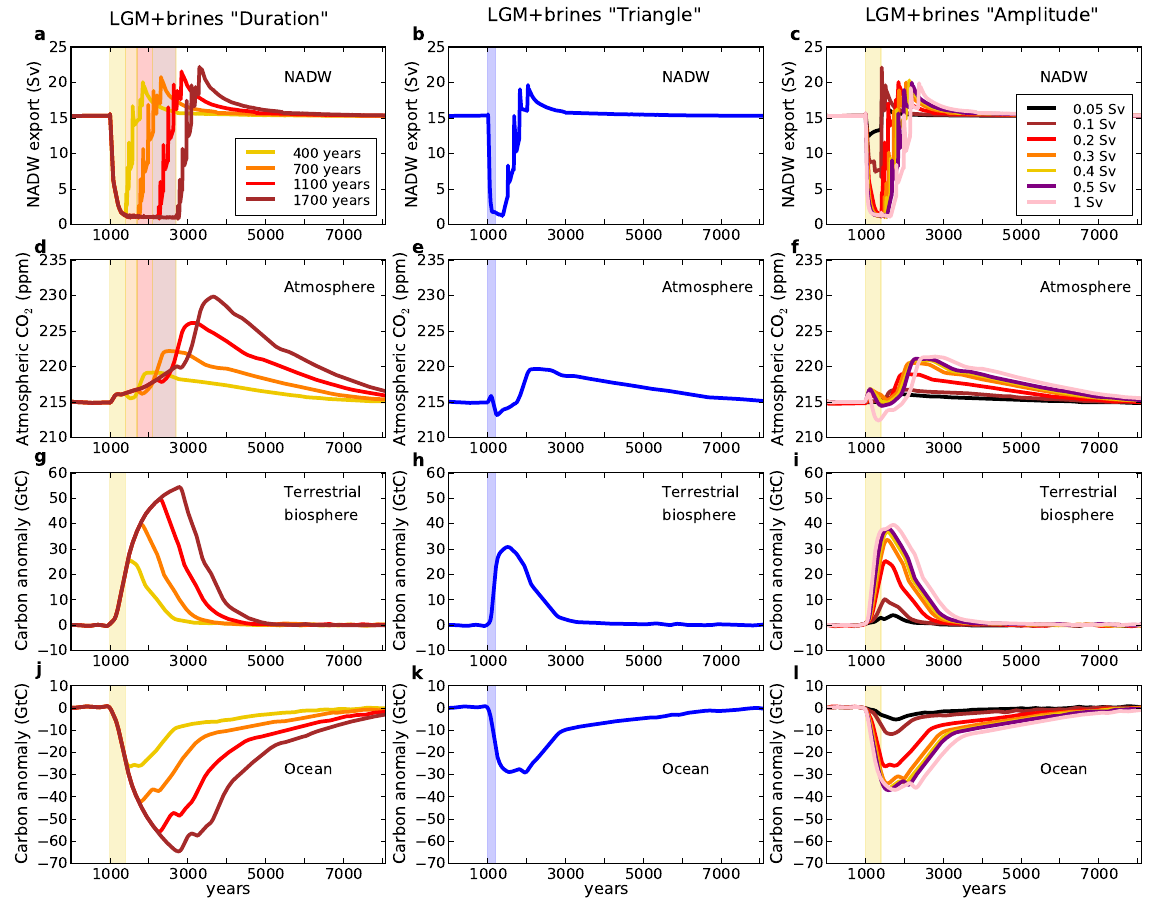
Fig. 12. Evolution of (a, b, c) NADW export (Sv) (maximum of the AMOC), (d, e, f) atmospheric CO 2 (ppm), (g, h, i) carbon content anomaly in the terrestrial biosphere (GtC) and (j, k, l) carbon content anomaly in the ocean (GtC) during the simulations with the Last Glacial Maximum background climate state and taking into account the sinking of brines (LGM+brines). The fresh water flux is added into the North Atlantic and varies as described in Fig. 1 for the three types of experiments: (a, d, g, i) “Duration”, (b, e, h, k) “Triangle” and (c, f, i, l)